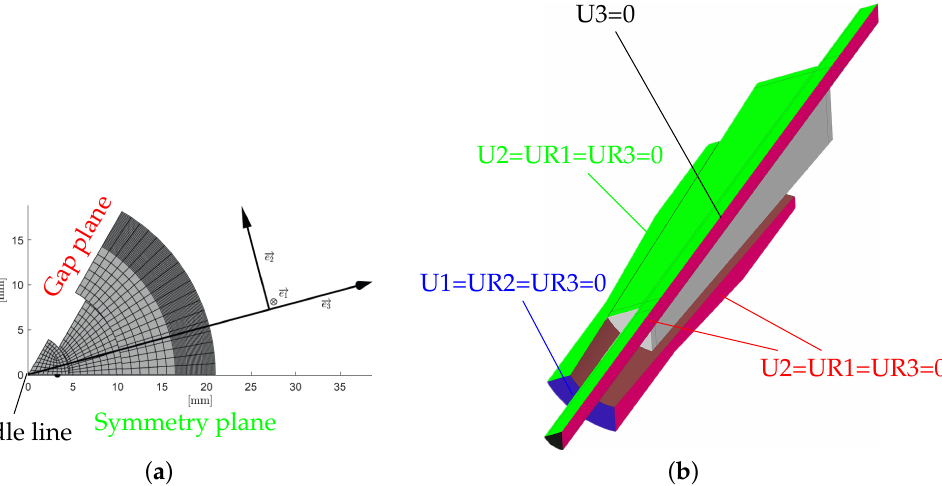
Figure 6. Definition of the boundary conditions. ( a ) Definition of planes and coordinate system; ( b ) visualization of boundary